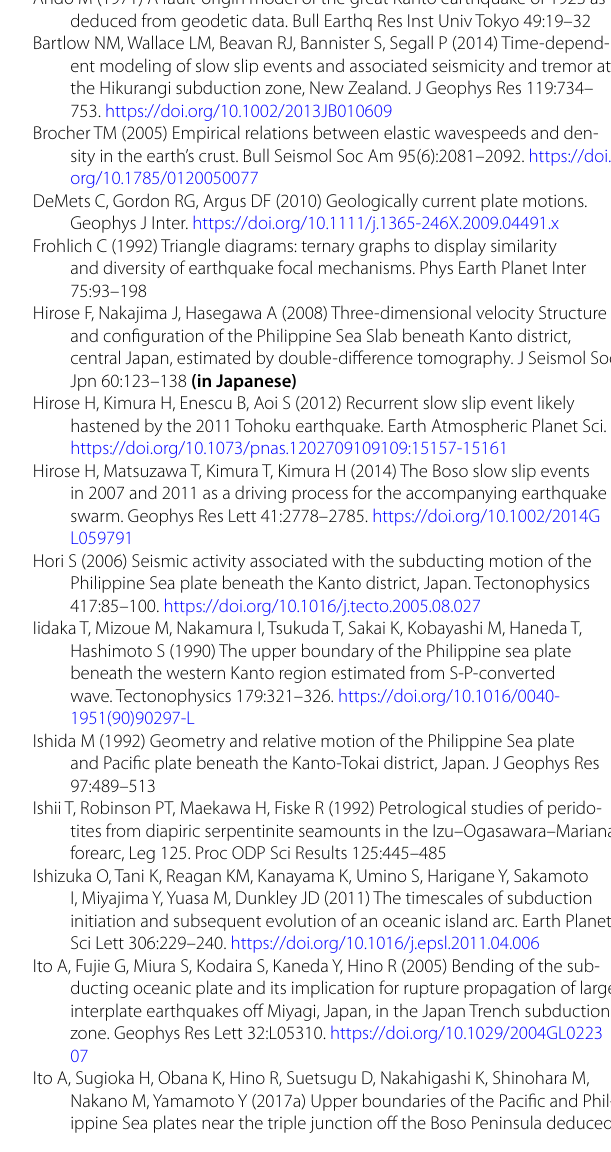
(LTOBSs). Figure S2 : Histogram of the magnitudes for local earthquakes. Figure S3 : Example of seismic record for a local earthquake. Figure S4 : Ray paths of seismic phases isolated from teleseismic P wave for seafloor observation. Figure S5 : Hypocenters determined by tomoDD.